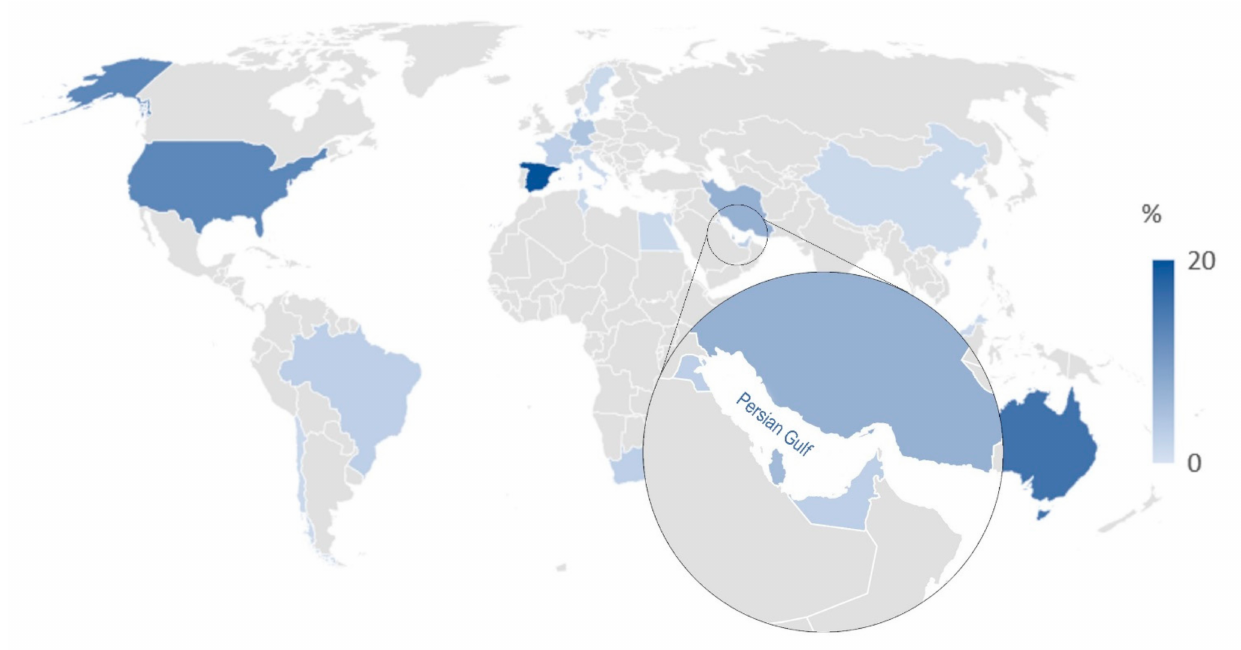
Figure 1. Distribution of water desalination LCA studies worldwide